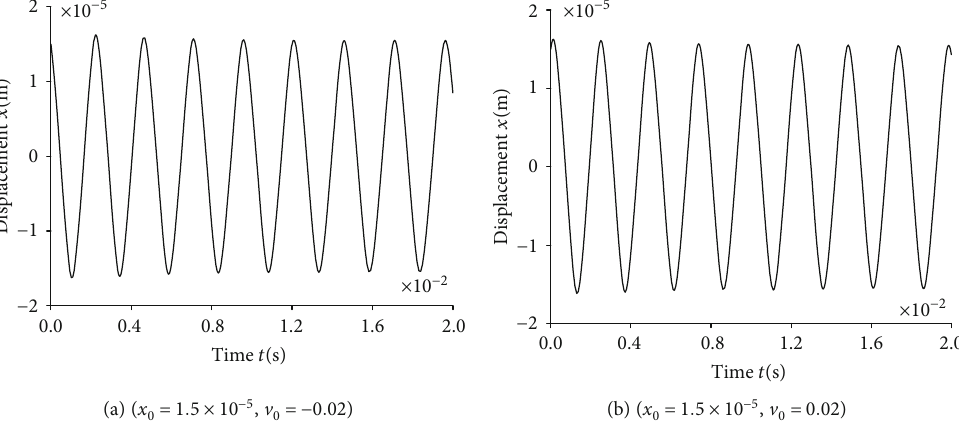
= 1 : 8A , q = 1 : 6 × 10 − 4 m 3 /s 0 0